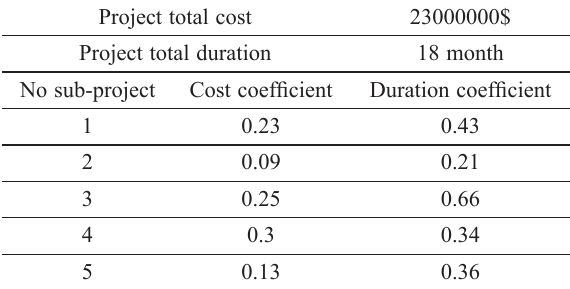
Table 2. Project characteristic